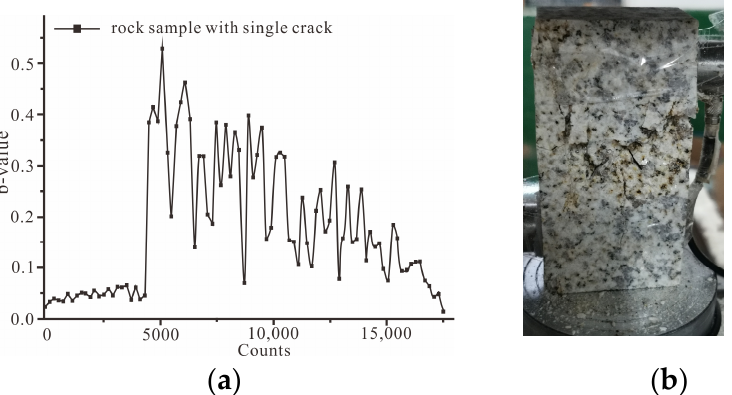
Figure 11. The b -value of intact rock sample. ( a ) The curve of the b -value of intact rock sample; ( b ) the failure of intact rock sample.